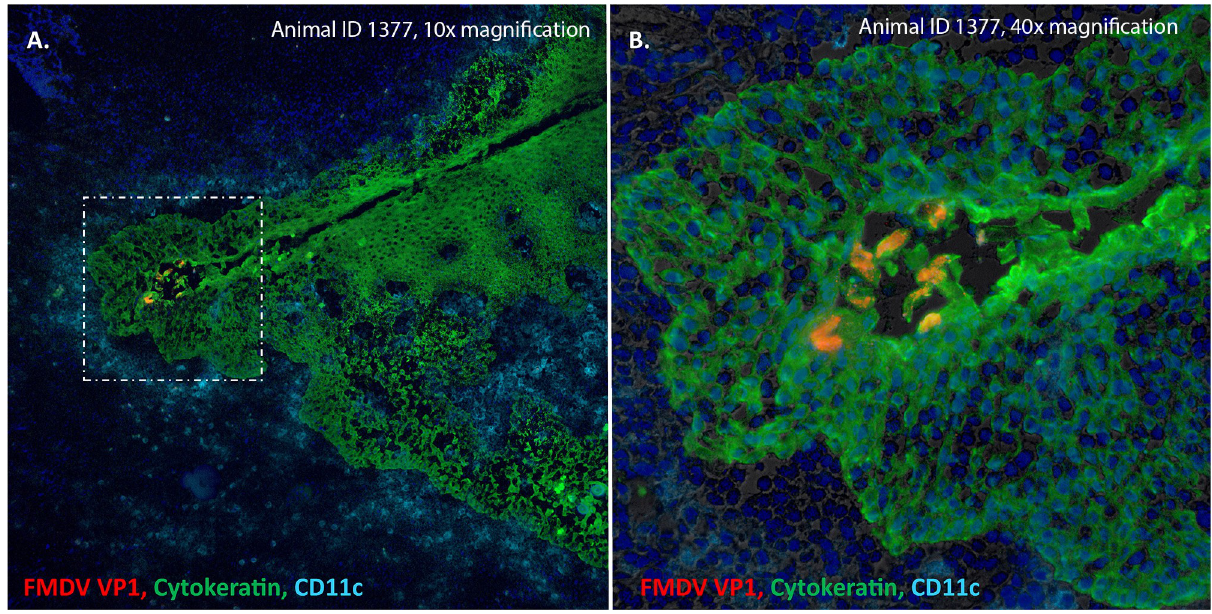
Fig 5. Persistent FMDV infection in ovine palatine tonsil epithelium. FMDV VP1 (red) localizes to cytokeratin+ epithelial cells (green) in superficial epithelial layers of the proximal (deep) aspect of a palatine tonsil crypt at 35 days post virus challenge (animal ID 1377). Abundant quantities of CD11c + presumptive antigen-presenting (cyan) cells are present in the surrounding tissue, but do not colocalize with viral antigen. A = 10x magnification. B = 40x magnification with differential interference contrast.